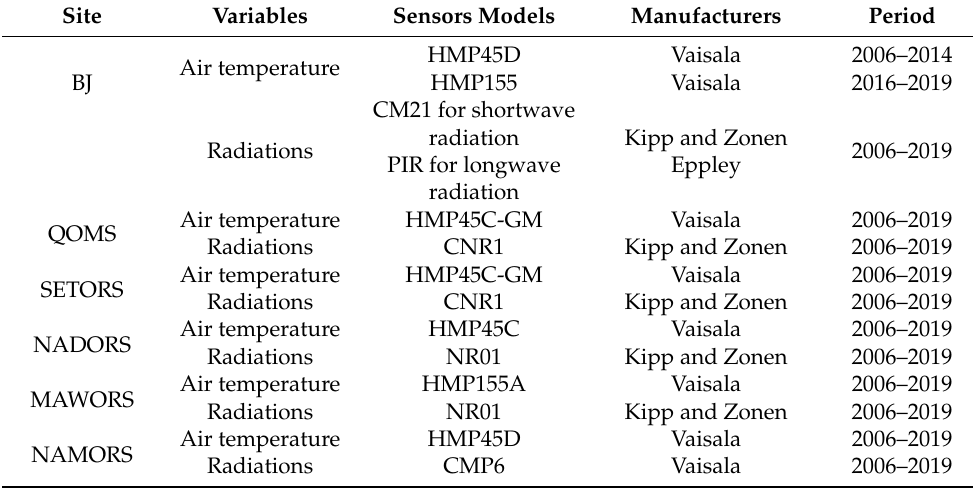
Table 2. List of the detailed information on observation items